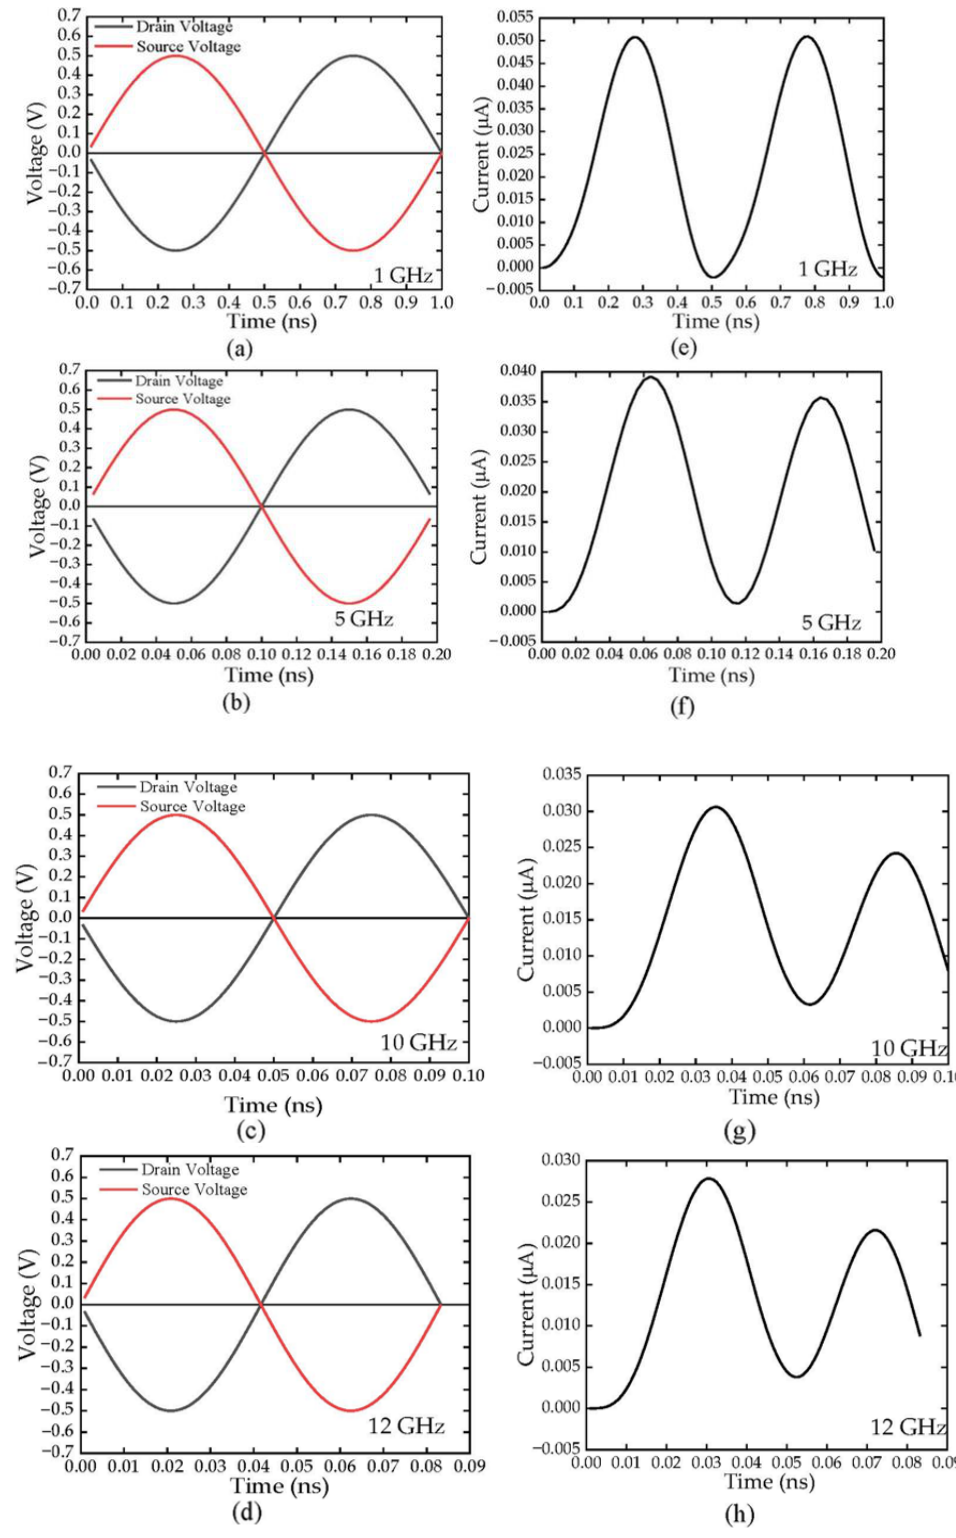
Figure 8. The AC signal inputs at ( a ) 1 GHz, ( b ) 5 GHz, ( c ) 10 GHz, and ( d ) 12 GHz with the rectified output DC current in ( e – h ), respectively.